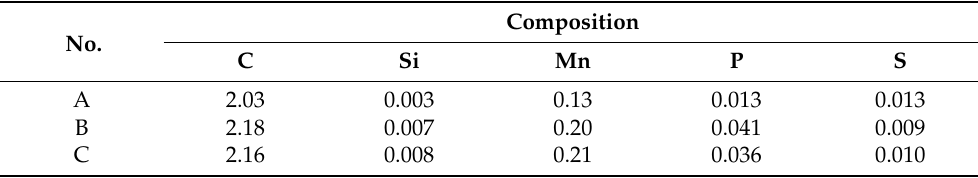
Table 3. Chemical composition of the final hot metal (wt.%).